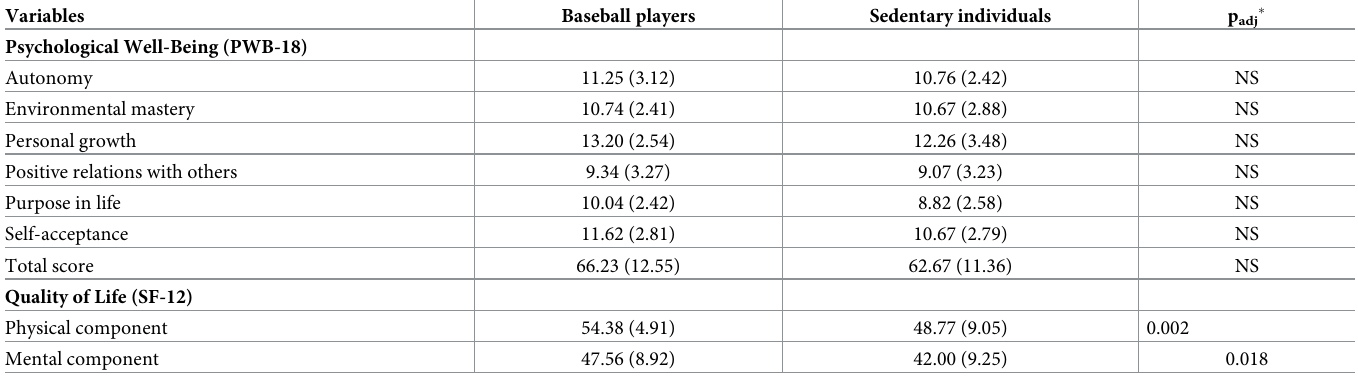
Values are mean (SD). NS, not significant. �